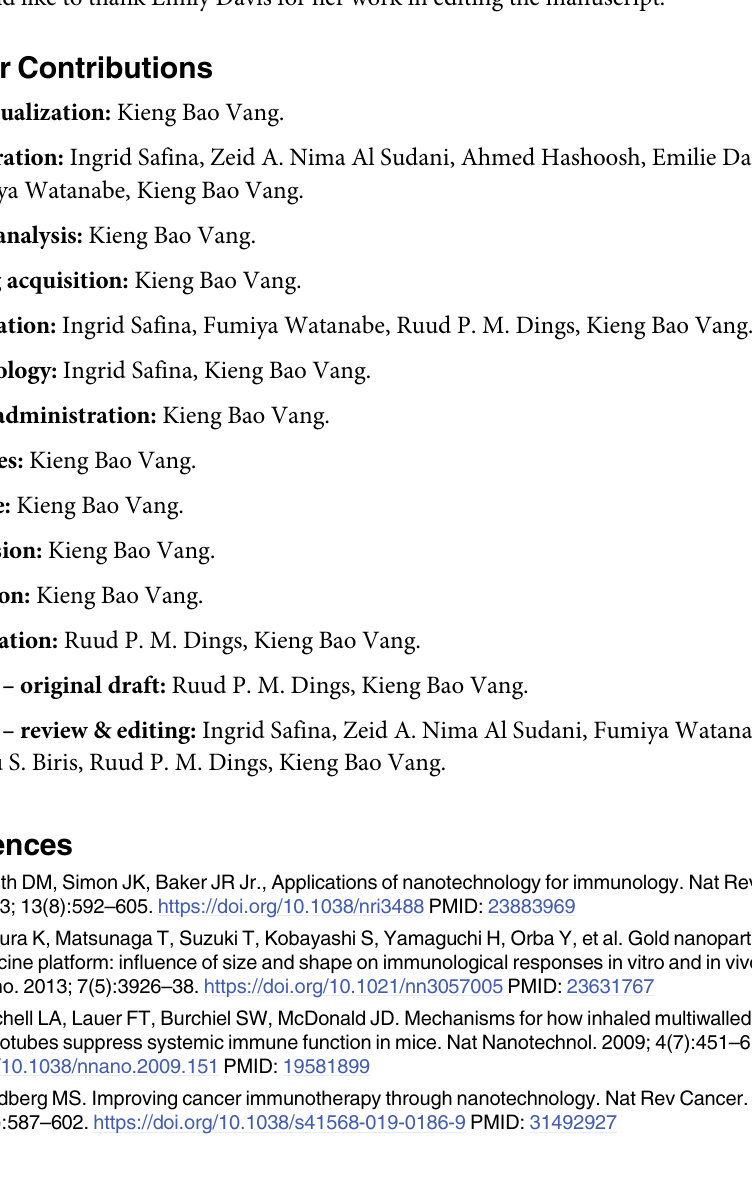
(5 μ g/ml), AuNR (100 μ g/ml), and AuNR/Ag (100 μ g/ml) for up to 72 hours. After 72 hours, the cells were harvested, washed, and prepared for flow cytometry. The data is based on the live gate. The green histogram represents cell proliferation based on eFlour 670 dilution over time. The data is representative of 2 independent experiments, n = 6 total. (TIF) S12 Fig. AuNRs do not impact the granulosity of the whole splenocytes. Whole splenocytes were untreated, treated with LPS (5 μ g/ml), treated with 100 μ g/ml AuNR, or treated with 100 μ g/ml AuNR/Ag for up to 72 hours. The scatter dot plot is representative of 3 independent experiments with at least 3 technical replicates.